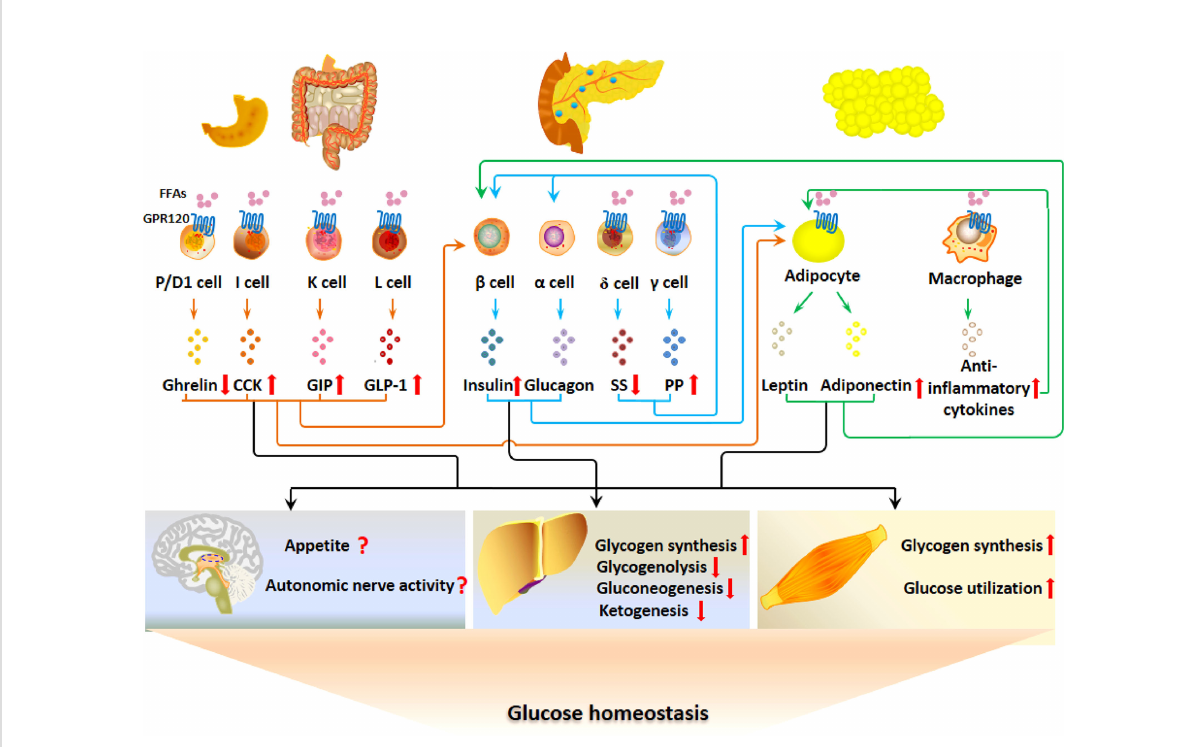
FIGURE 3 GPR120 regulates glucose metabolism via the G-P-A regulatory system. GPR120 activation after fat ingestion potentiates the secretion of GLP- 1, CCK and GIP with the inhibition of ghrelin. Meanwhile, GPR120 activation increases adiponectin secretion. The GI hormones and adiponectin may act on CNS, liver and skeletal muscles to inhibit appetite, increase autonomous nerve activity, stimulate glycogen synthesis, and promote glucose utilization. GPR120 regulates the secretion of SS and PP in islets, which may in fl uence the secretion of insulin in a paracrine manner. In addition, GPR120 regulates the function of adipocytes directly and indirectly via modulating the cytokine release from